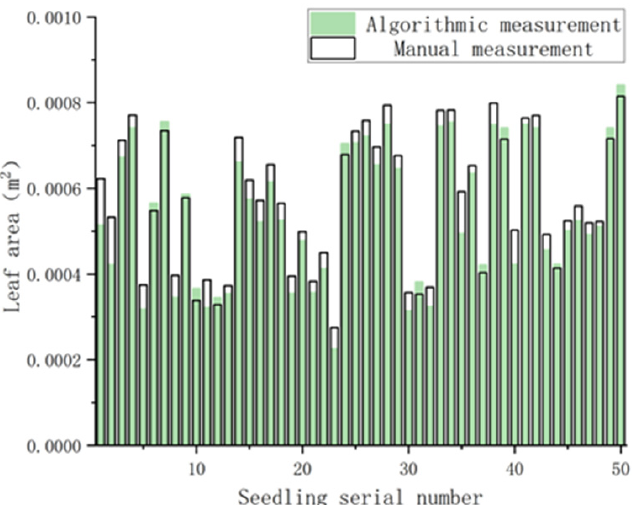
Figure 13. Comparison of manual and algorithmic measurements of the area of the first plug seeding.